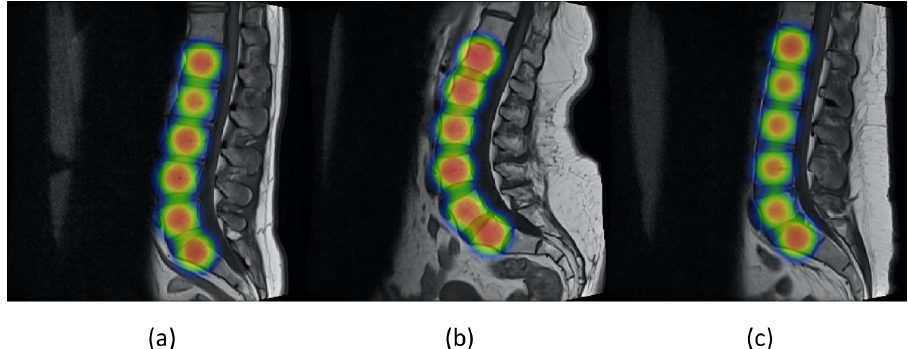
Figure 12. ( a – c ) represent the YOLOv5 visualization in heat maps obtained from its weights after training on the three different images.